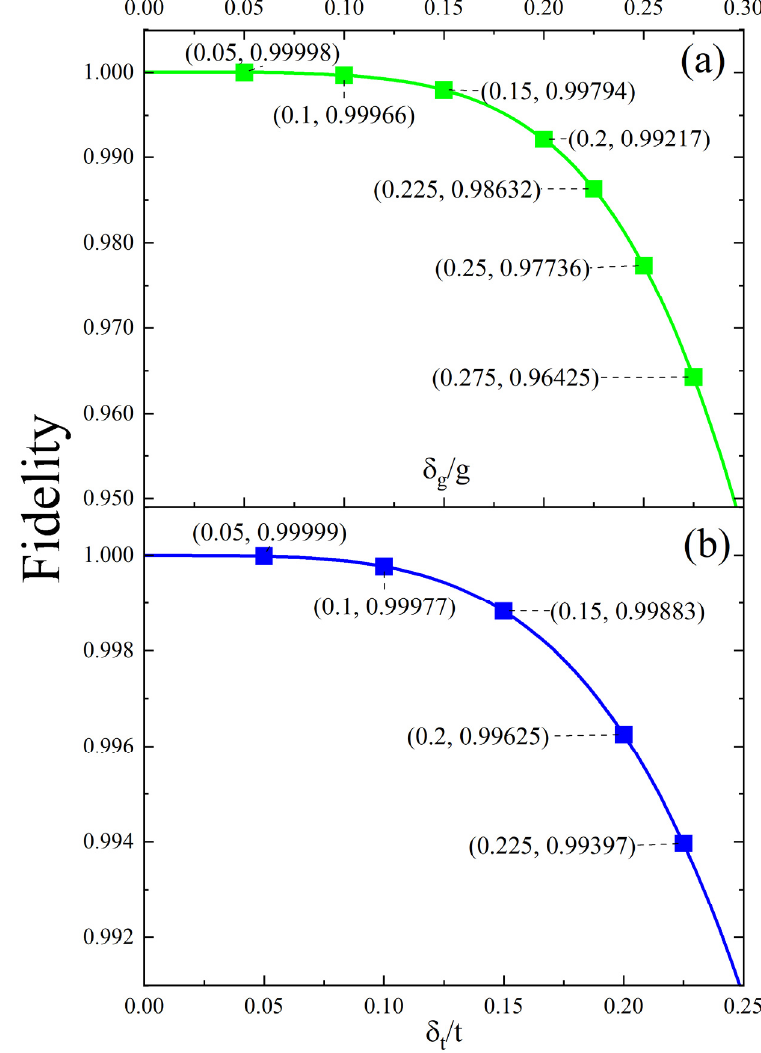
Figure 4. Fidelity of photonic two-qubit phase gate in the condition of deviation of g by the value δ g ( a ) and deviation of t by the value δ t ( b ), where the other parameters are chosen to be the same as those in Figure 3 .